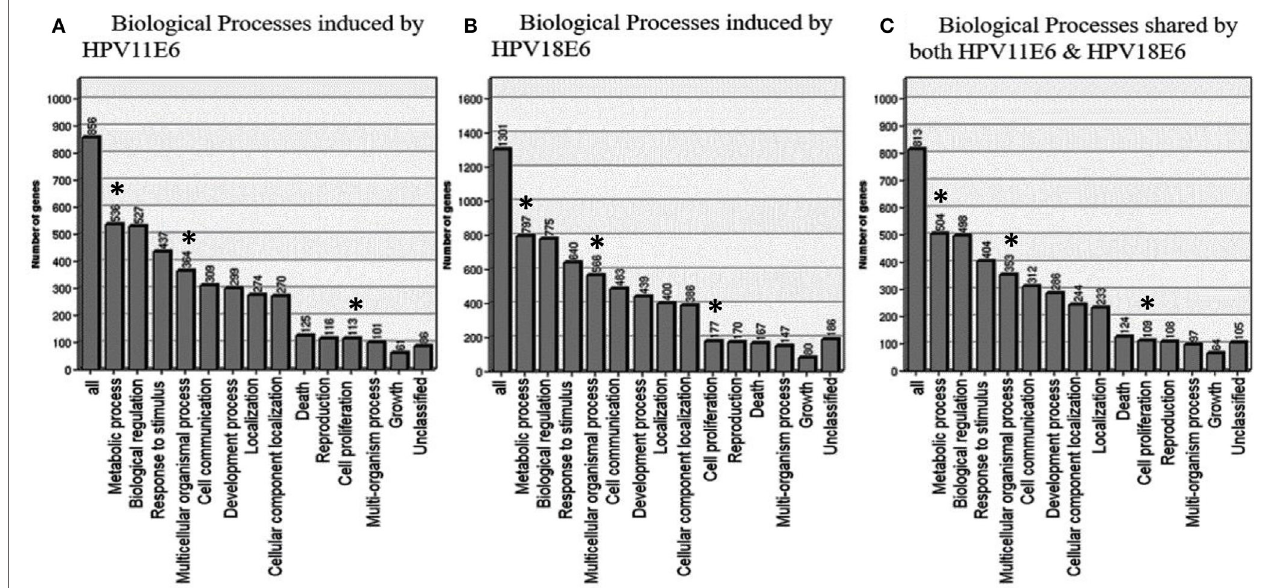
FigUre 5 | GOTree machine biological process analysis: graphical representation of enriched biological processes of differentially expressed genes (DEGs) following the expression of (a) HPV11E6, (B) HPV18E6, and (c) processes shared by both HPV11E6 and HPV18E6. HaCaT cells infected with HPV11E6 or HPV18E6 altered numerous unique biological processes, with 536 and 797 genes, respectively, being involved in the metabolic processes. While 504 DEGs shared by both HPV11E6 and HPV18E6 were also associated with the metabolic processes. The metabolic process is the most significantly enriched gene ontology (GO) function in the biological processes having the highest number of DEGs affected by HPVE6. Asterisks (*) depict the number of DEGs regulating the common GO processes that are associated with hallmarks of cancer following infection by